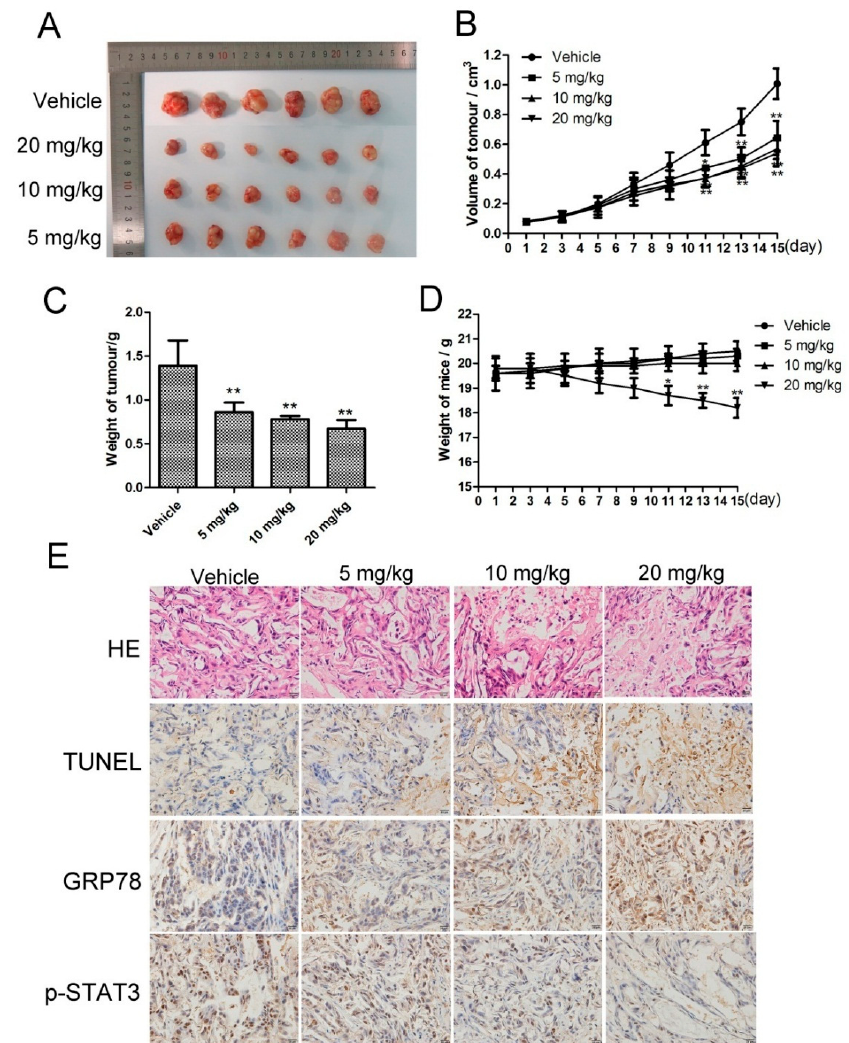
Figure 6. CK inhibited in vivo liver cancer xenograft tumor growth. ( A ) At the end of the experiment, resected tumors from each group were collected and imaged. ( B ) Tumor volumes were calculated after treatment with CK or normal saline (Vehicle) once every two days for 15 d. Data are presented as mean ± SD; Statistics were done by one-way ANOVA, Dunnett text and Bonferroni text. * p < 0.05, ** p < 0.01 vs. Vehicle. ( C ) Tumors weights for each group were measured on the last day of the experiment (day 15). Data are presented as mean ± SD; Statistics were done by one-way ANOVA and Dunnett text. * p < 0.05, ** p < 0.01 vs. Vehicle. ( D ) Body weights of each group were measured once every two